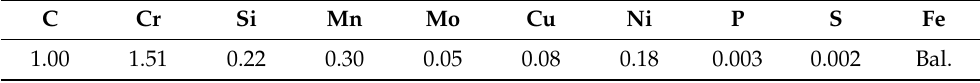
Table 1. Actual chemical composition (wt%) of GCr15 steel balls used during experiment.